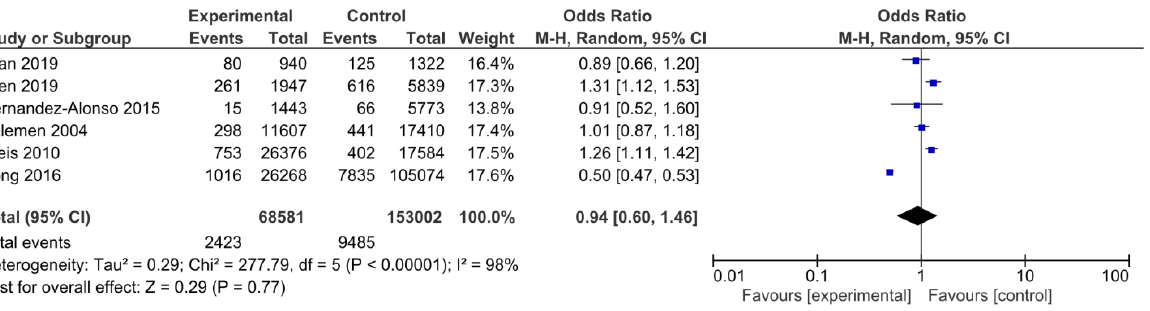
Figure 3. Forest plot for the association between HP intake and risk of cardiovascular mortality. [23,25,49,53,55,56,58] 3.3.2. Stroke